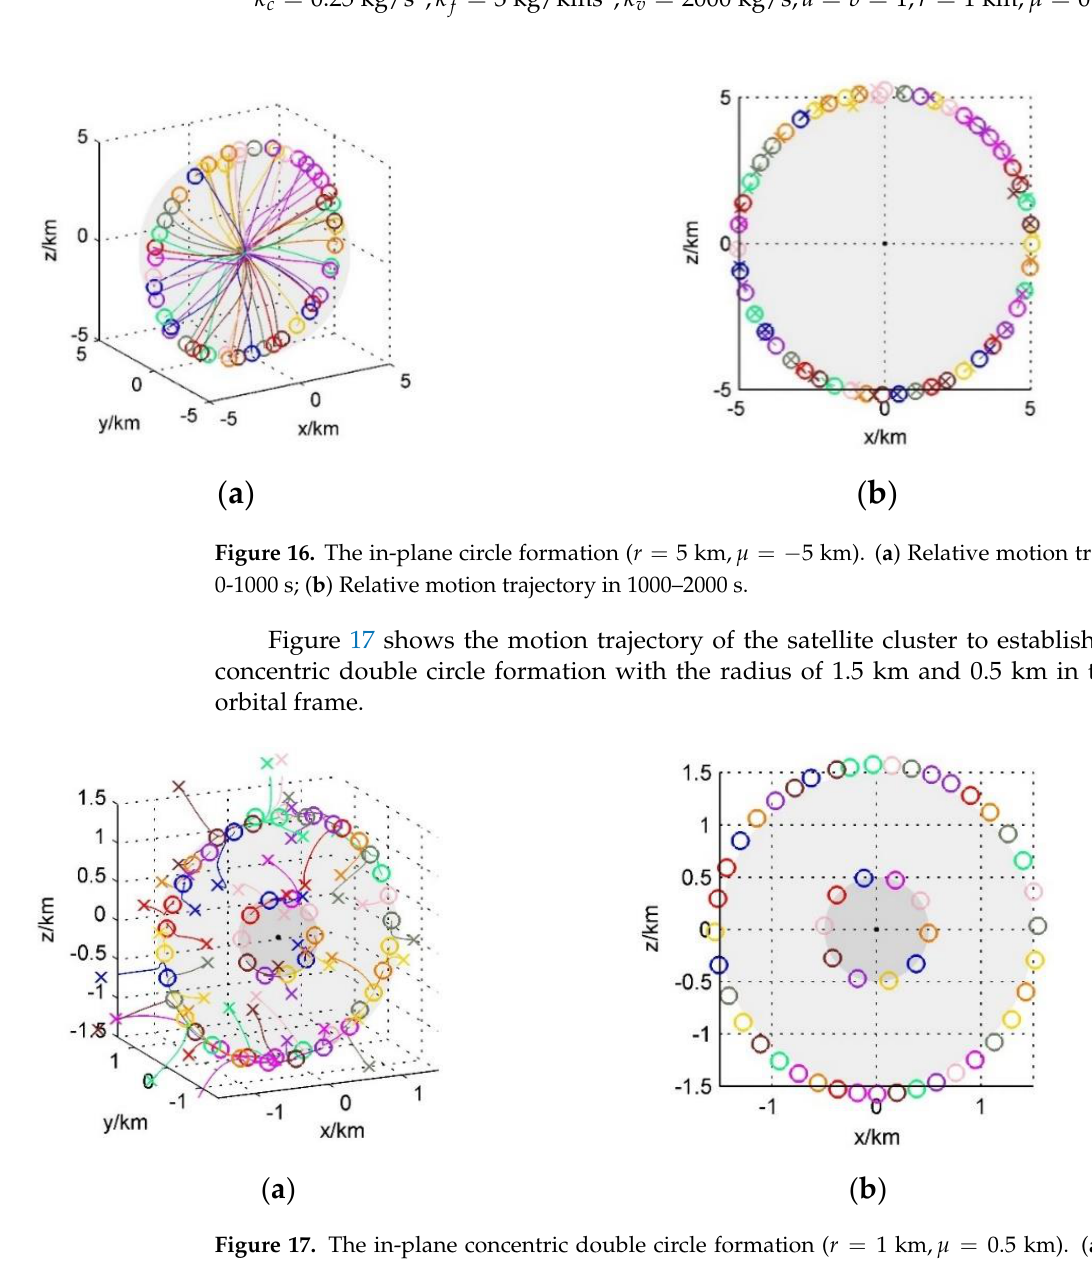
( b ) Figure 18. The in-plane disk formation ( 0km, 1km r = = −